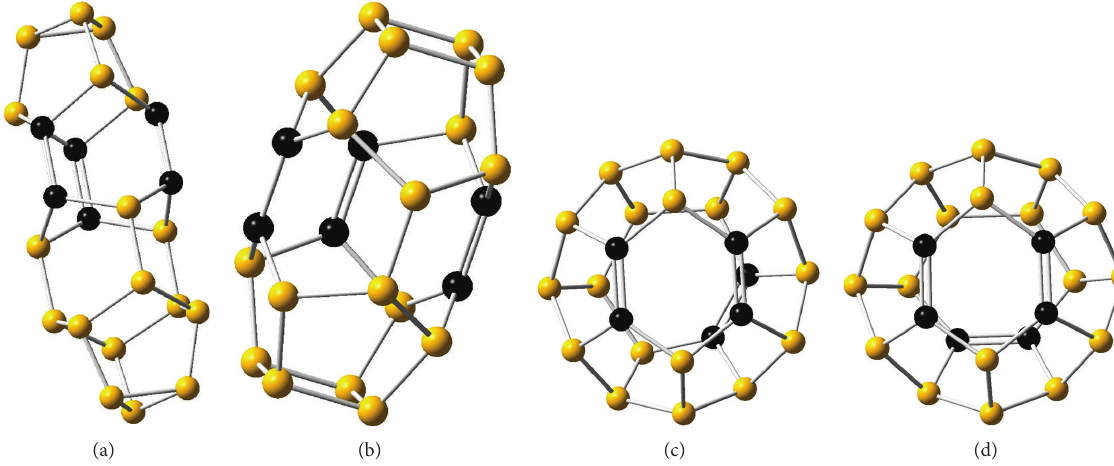
Figure 3: Isomers of N 18 C 6 : (a) isomer T, (b) isomer S, (c) isomer H1, and (d) isomer H2. Carbon atoms are shown in black, and nitrogen atoms are shown in yellow.